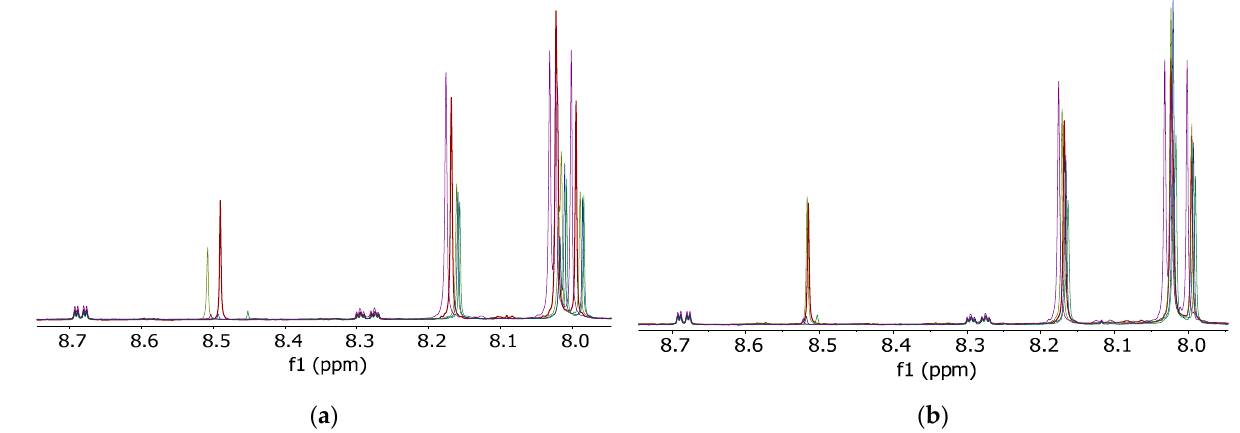
Figure 3. Superposition of five spectra in the range of δ H = 7.95–8.75 ppm of fat extracts from trout samples. ( a ) Solvent was untreated (D 1 )chloroform and (D 4 )methanol (2/1, v / v ); ( b ) mitigated (D 1 )chloroform and (D 4 )methanol (2/1, v / v ). 1 H-NMR spectra, 400 MHz, 290 K, referenced to δ TMS = 0.00 ppm. Signal assignment 8.17 ppm (singlet) hypoxanthine.